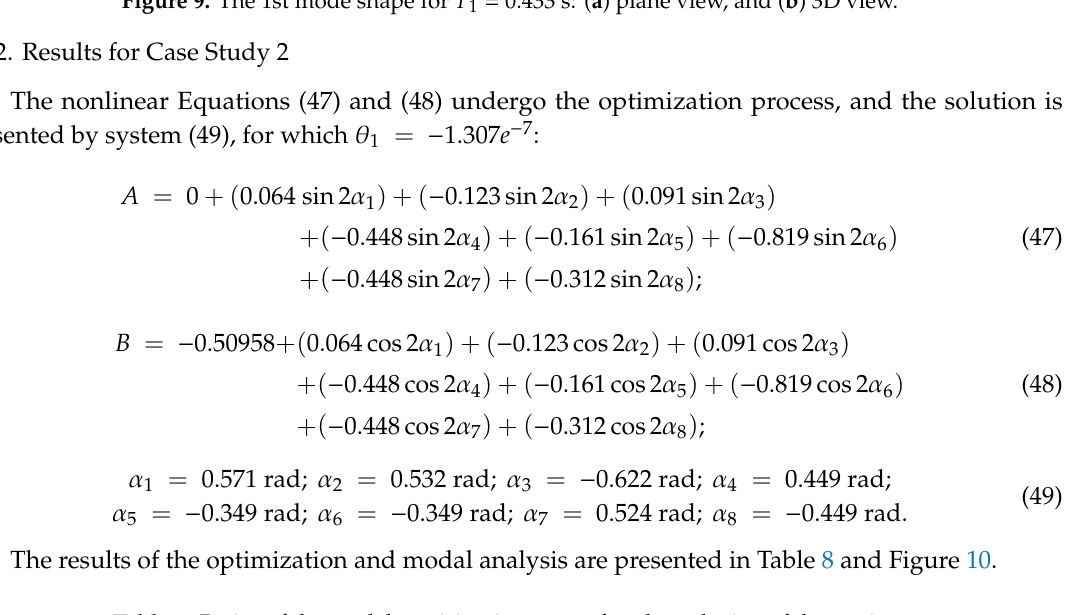
Table 8. Ratios of the modal participating mass after the reducing of the